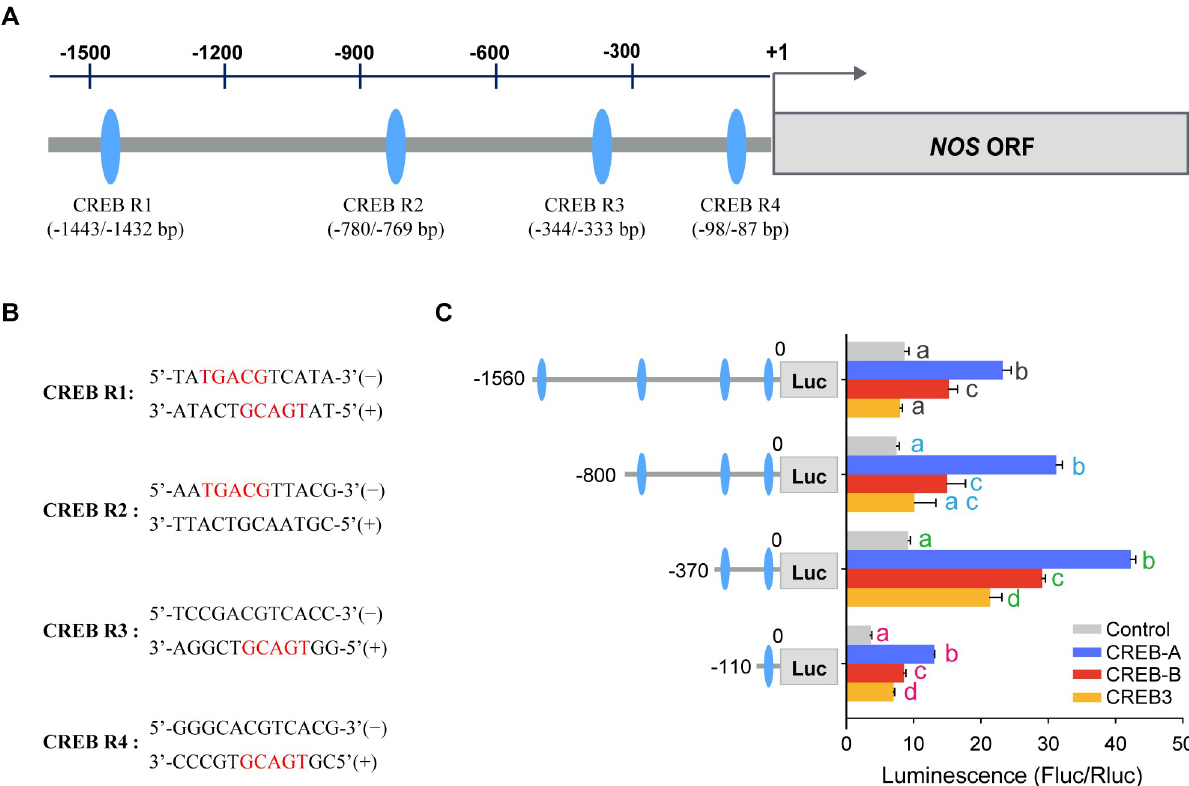
Fig 1. Transcriptional activity of CREBs for the upstream element of NOS in HEK293T cells. (A) Schematic representation of the location of CREB-response elements in the NOS promoter region. The grey bar and box indicate the promoter and coding region, respectively. The blue ellipses indicate CREB-response elements. Numbers indicate the distance from the translation initiation site (+1) of NOS . (B) Sequences of the four predicted CREB-response elements. Red letters show the core nucleotides of CREB-binding motif. (C) Effects of CREB over-expression on the progressive deletions of NOS promoter examined by dual-luciferase report system (n = 4 replicates). Data are indicated by mean ± s.e.m., one-way ANOVA, P < 0.05. Different letters in same color indicate